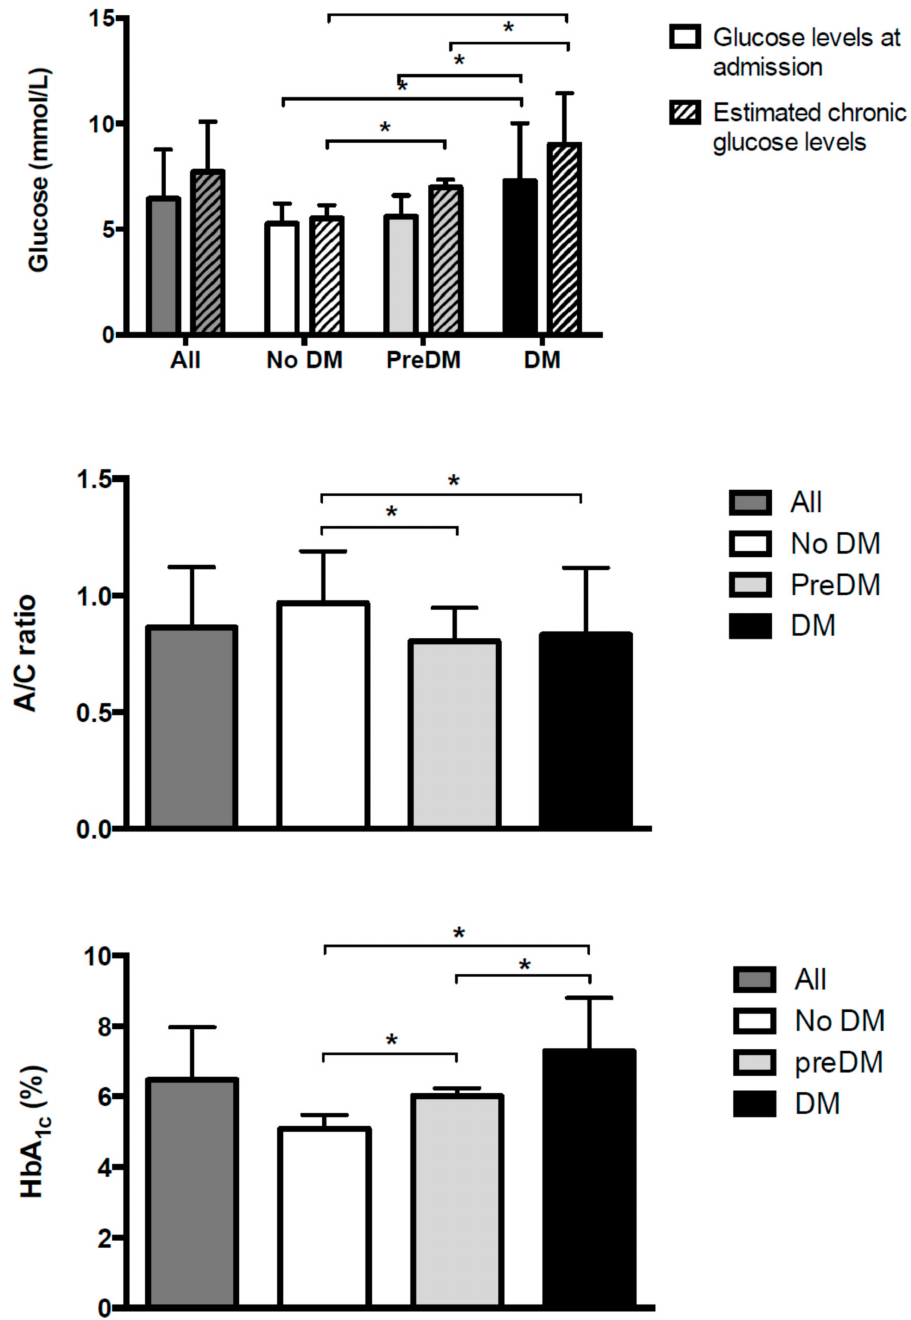
Figure 1. Glucose at admission and estimated chronic glucose levels (top panel), acute to chronic glycemic ratio (mid panel), and HbA1c (bottom panel) for subjects admitted to the hospital for acute heart failure (whole population and stratified by diabetes status) * p <